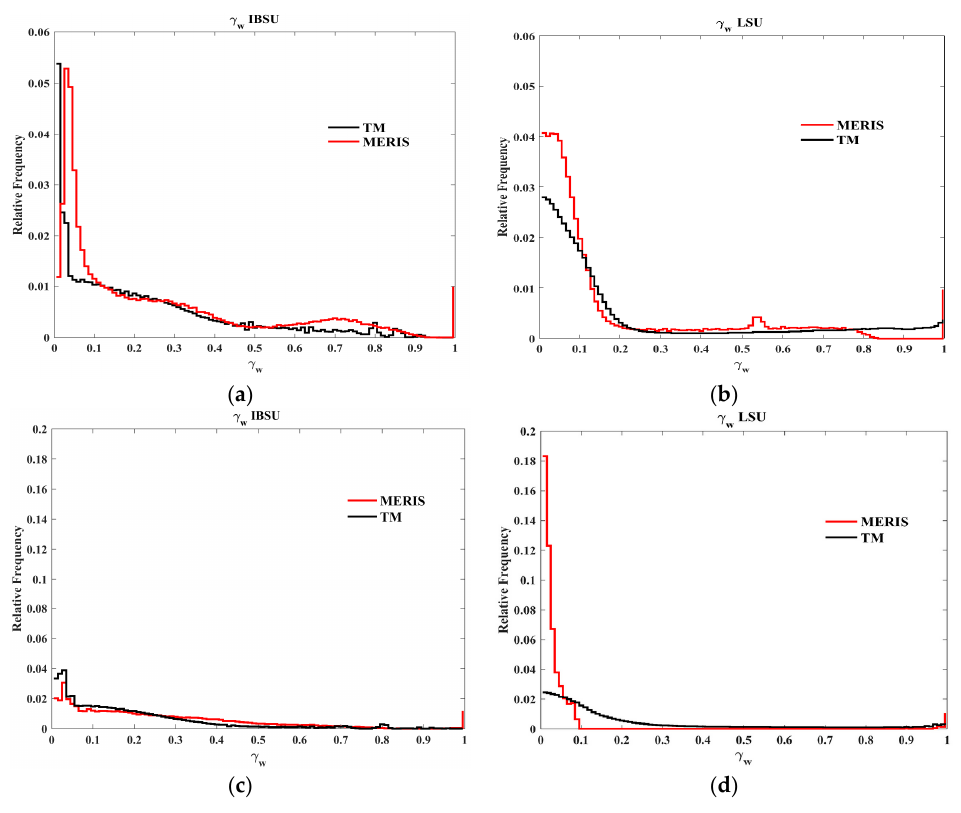
Figure 13. Histograms of γ w retrieved with MERIS and TM data: ( a ) IBSU on 17 April 2008; ( b ) LSU on 17 April 2008; ( c ) IBSU on 22 (TM) (MERIS) and 23 May 2009; ( d ) LSU on 22 (TM) and 23 (MERIS) May 2009.